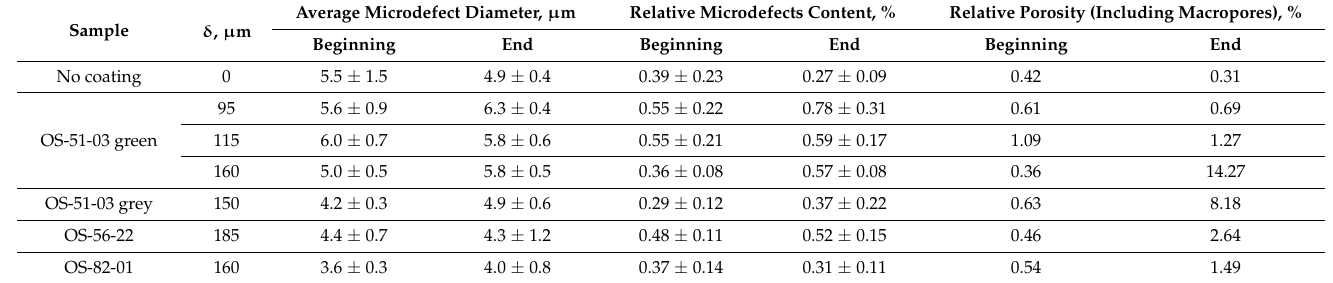
Table 4. Micro- and macrodefects in the weld.